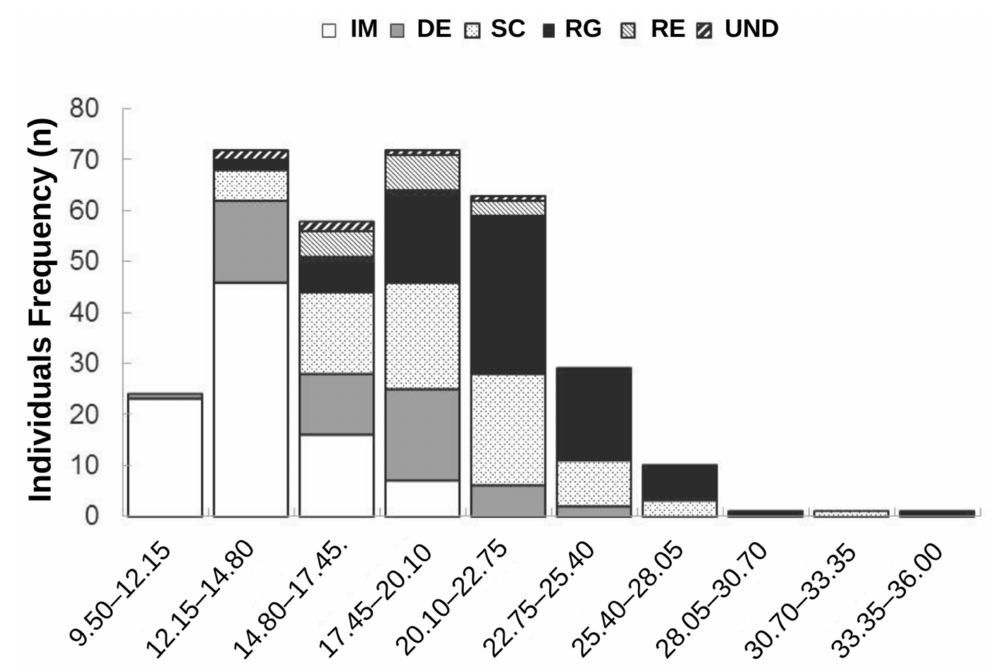
Figure 3. Frequency distribution of specimens by gonad stage was IM: immature, DE: development, SC: spawning-capable, RG: regression, RE: regeneration, UND: undetermined. Total length (TL, cm) of Genyatremus luteus , captured from April/16 to April/17, Ajuruteua peninsula, Bragança, PA, Brazil. Totaling 331